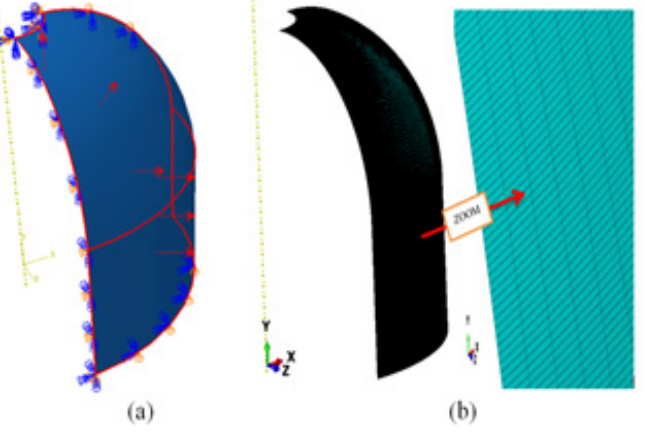
Figure 5. COPV FEM: ( a ) Boundary condition and loading ( b ) meshed model.